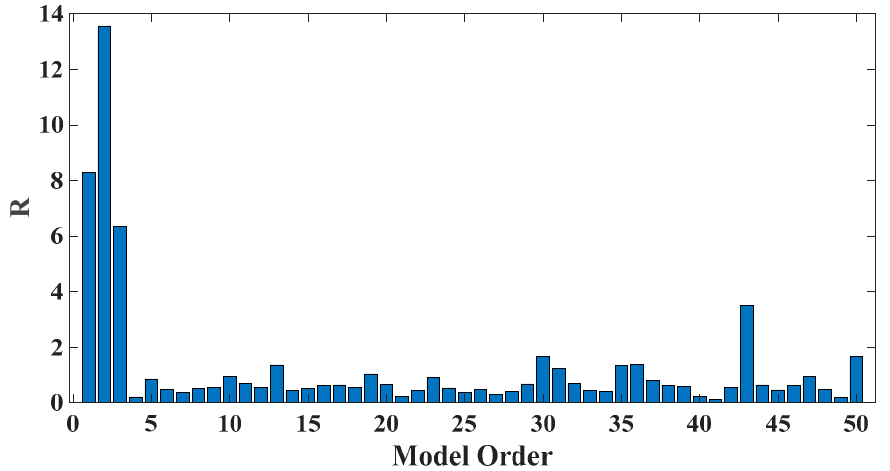
Figure 31. Evaluation index of damage detection results using various AR orders (the case of removing braces on the third floor).